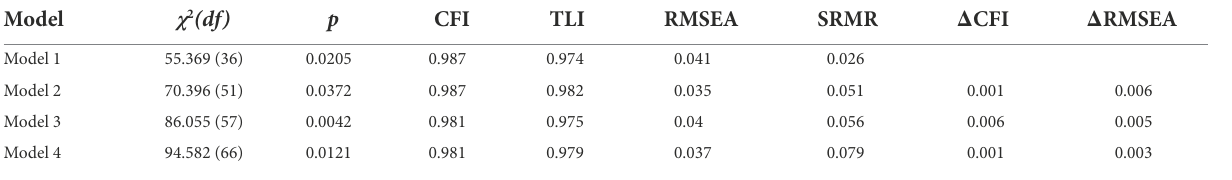
TABLE 3 Measurement invariance test of L2 grit using bifactor CFA.